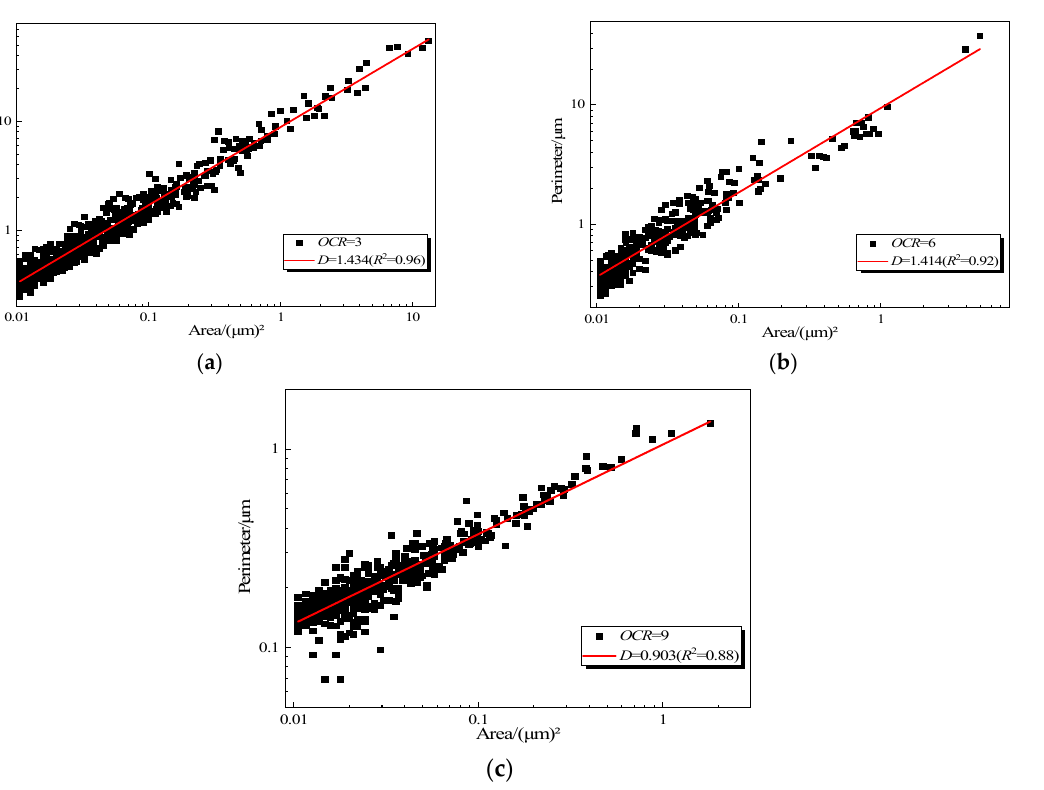
Figure 8. Fractal dimension of soil samples under different overconsolidation ratios: ( a ) OCR = 3; ( b ) OCR = 6; ( c ) OCR = 9.